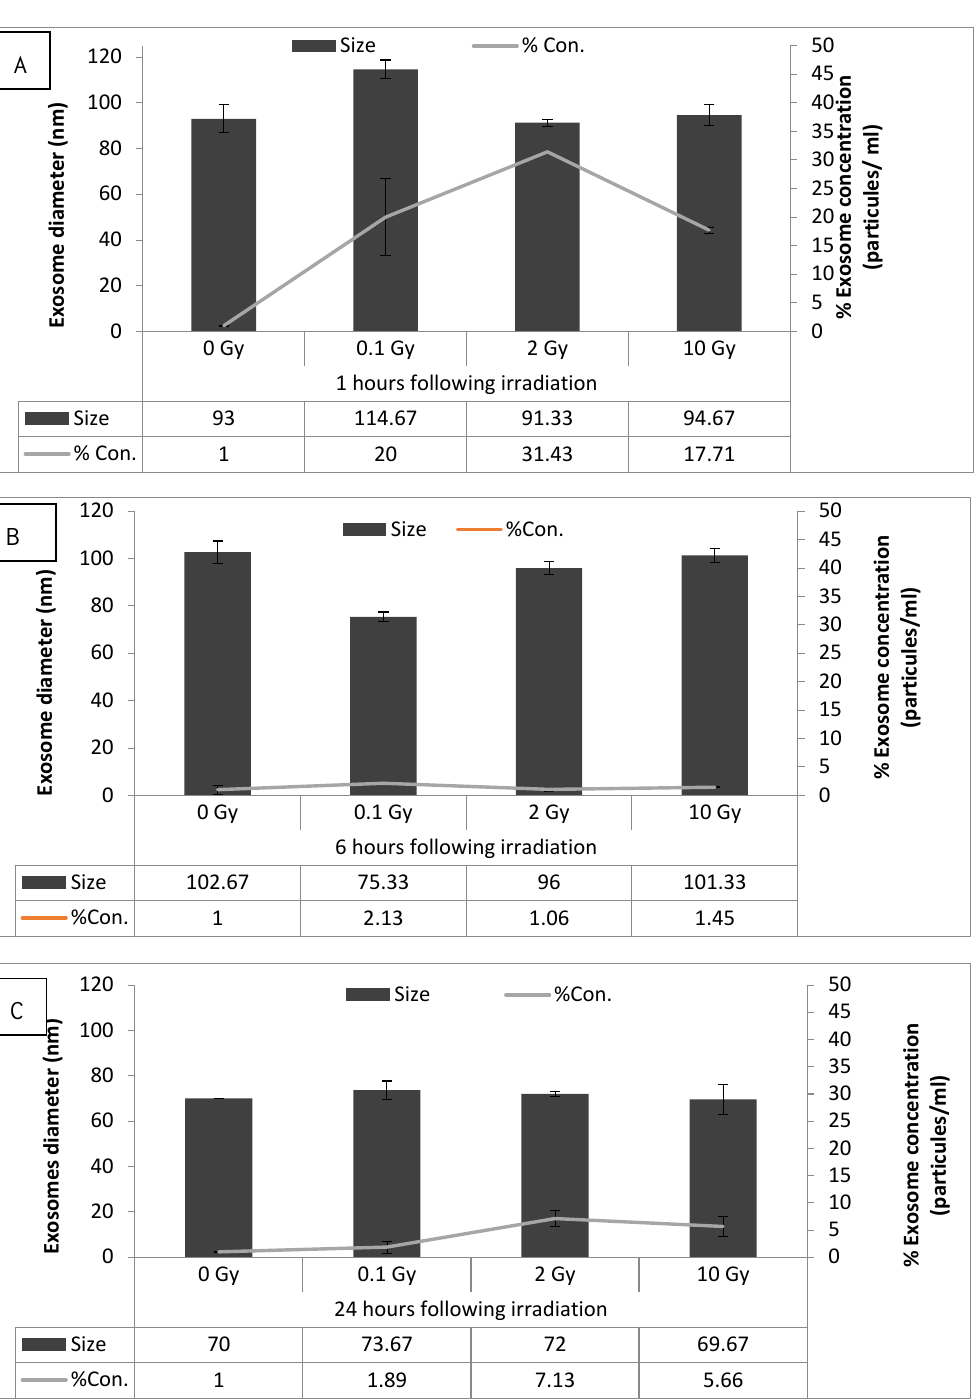
6 of 13 Figure 3. Results for older cells (~17% senescent cells). The percentage senescence over different time points (30 min, 24 h, 48 h, 72 h, and 10 days) after x-ray irradiation with 2 Gy or 10 Gy is shown. The highest level of senescence is found in 10 Gy cells 10 days after radiation. We found a significant difference for all three radiation groups when comparing the 30 min sample to the 10 day samples (0 Gy P Value 0.0094, 2 Gy P Value 0.0080, and 10 Gy; P value < 0.0001). 3.3. Senescence Bystander Effect After investigating direct induction of senescence through IR we then explored the potential for these effects to be further mediated through bystander signaling. The production and release of exosomes from irradiated cells into culture media was investigated. For these experiments we chose to work exclusively with cells at a passage corresponding to the younger cells investigated above. Medium was collected from cultures at 1, 6, and 24 h after exposure to 0, 0.1, 2, and 10 Gy X-rays. Using tunable resistive pulse analysis, the average size of the exosomes and their concentration were determined. As shown in Figure 4, the size of exosomes was within the expected range (30–150 nm). At every dose the concentration of exosomes was found to increase with post-irradiation time